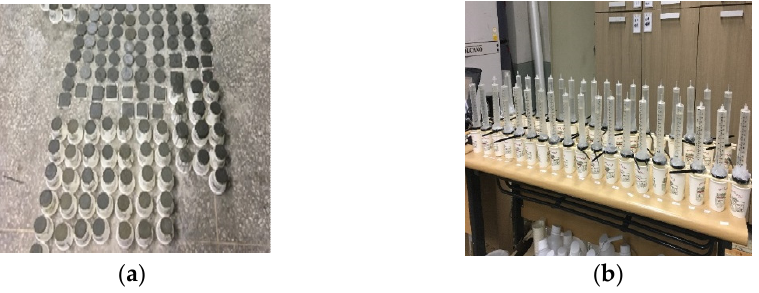
Figure 6. Water permeability test: ( a ) specimen production for water permeability test, ( b ) a view of the water permeability test.